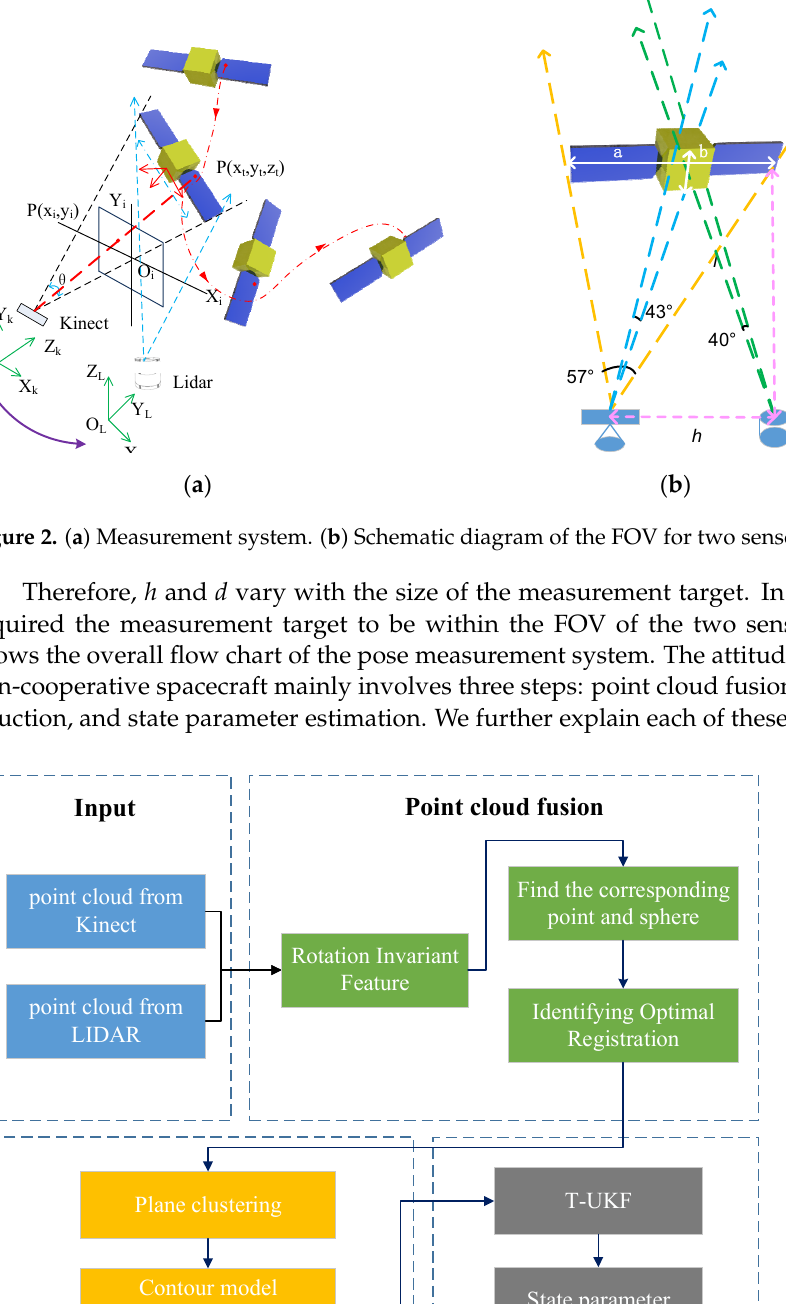
Figure 3. Algorithm structure.